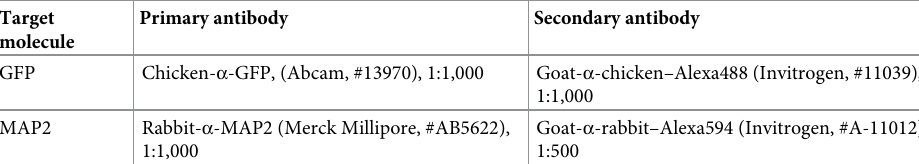
Table 1. Antibodies used in immunocytochemical staining AU : PerPLOSstyle ; IhaveaddedatitleandacalloutforTable 1 : Pleasecheckthatthesearesuitable : Ifnot ; pleaseedit :